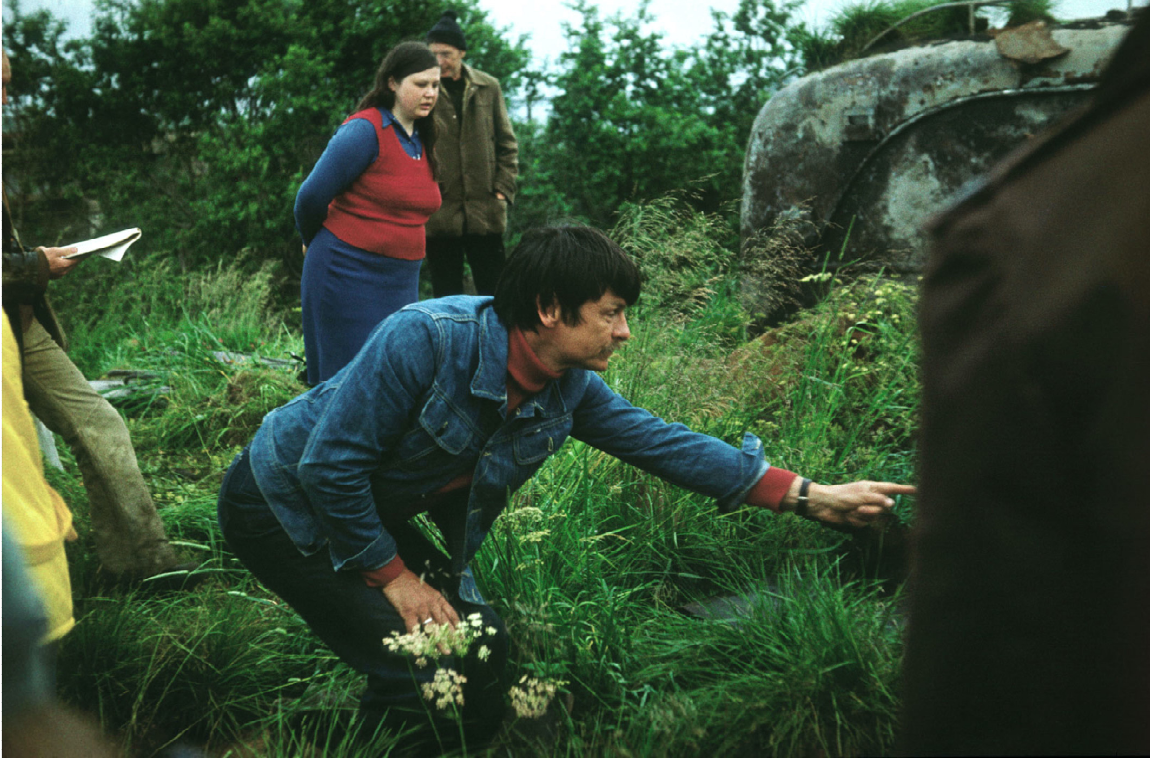
Figure 5. Andrei Tarkovsky surrounded by plants during the shooting of Stalker (1979) © Serguei